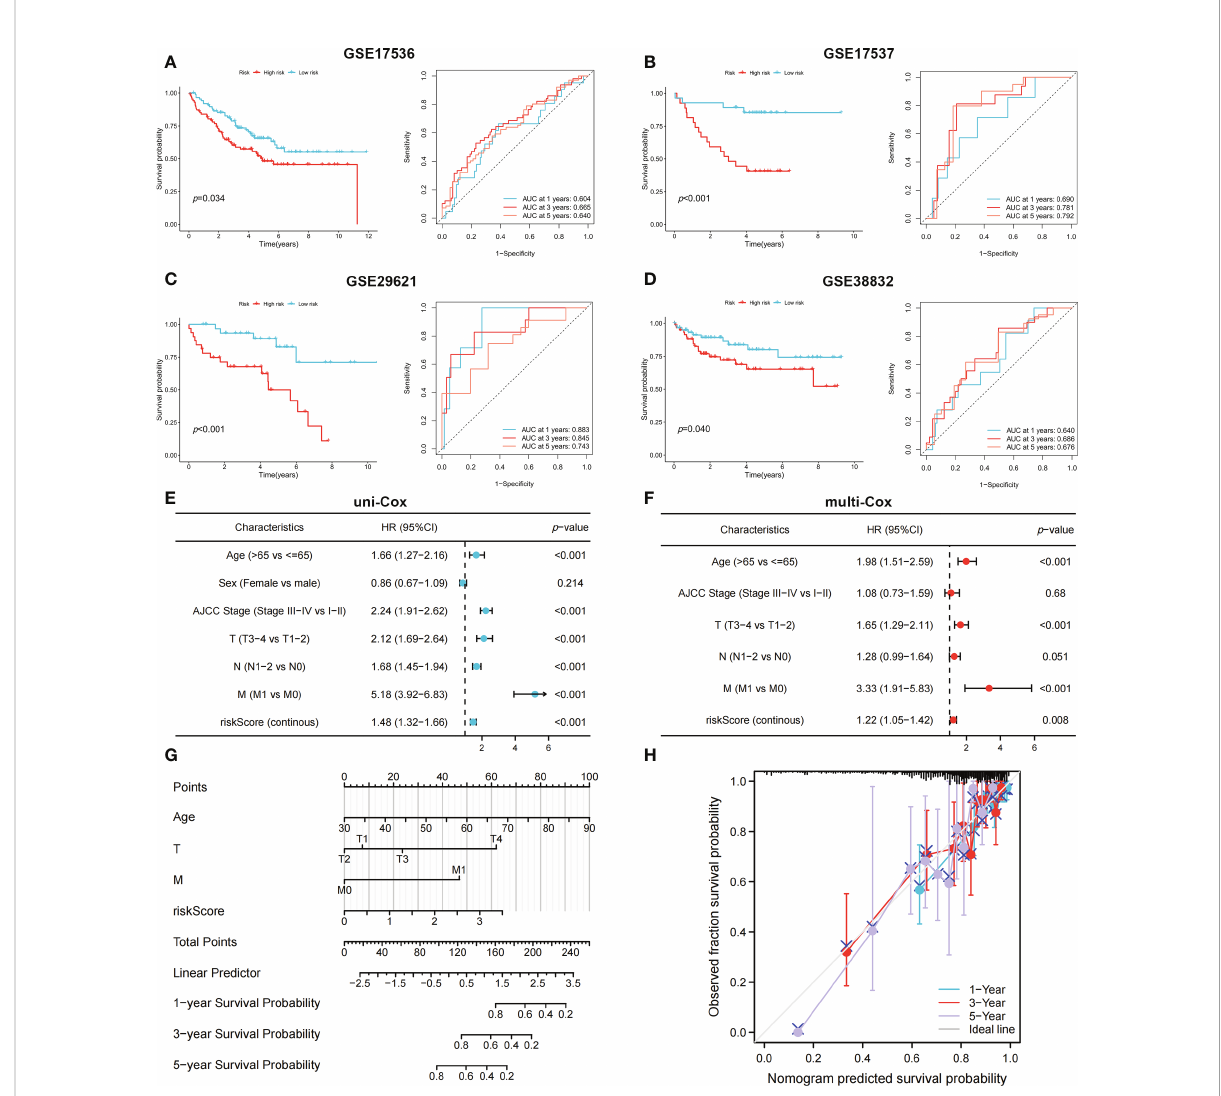
FIGURE 4 The KM and ROC methods were used to evaluate the ef fi ciency of the risk score at predicting patient survival and construction of the nomogram model. (A – D) KM and ROC curves showing the prognostic value in multiple cohorts. Forest plots of univariate (E) and multivariate (F) Cox regression analyses in patients with CRC. (G) Construction of the nomogram model using risk score and other clinical features. (H) Calibration plot showing the differences between nomogram-predicted survival rates and actual survival